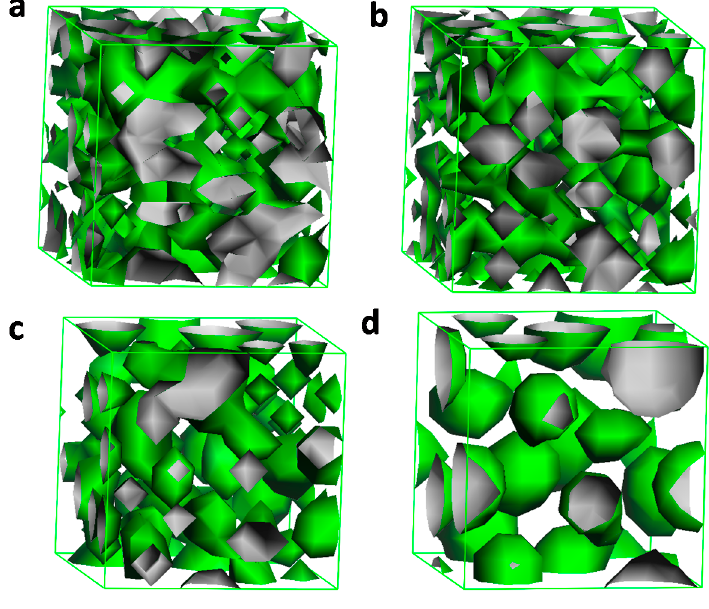
Figure 8. Simulation of micelle formation of 20% C n PDB in EAN at room temperature at different time steps: ( a ) 3; ( b ) 10; ( c ) 100; ( d ) 20,000. The size of the simulation model is 10 × 10 × 10 in DPD